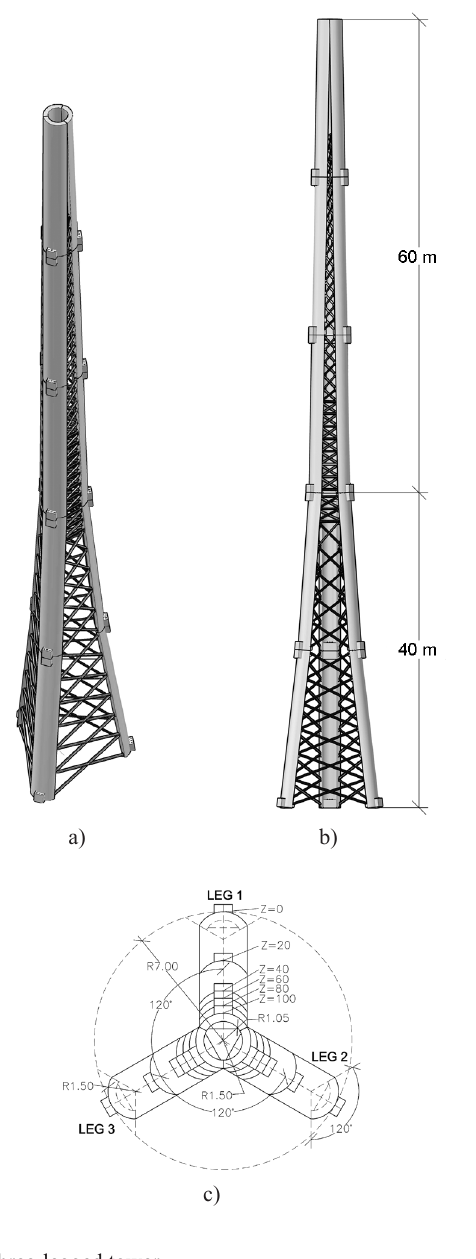
Fig. 1. Three-legged